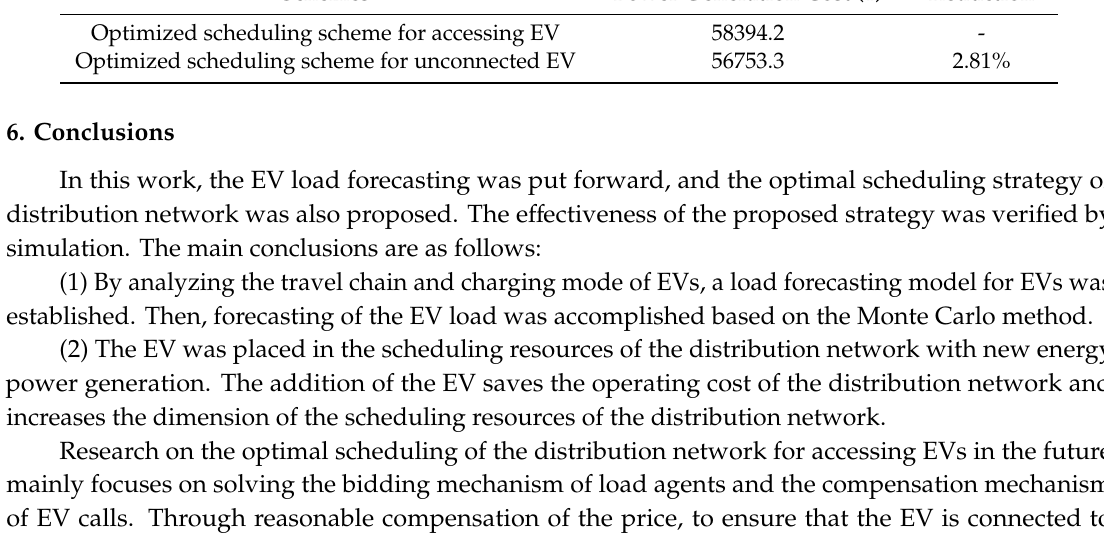
Table 5. Power generation costs of two optimized scheduling schemes.